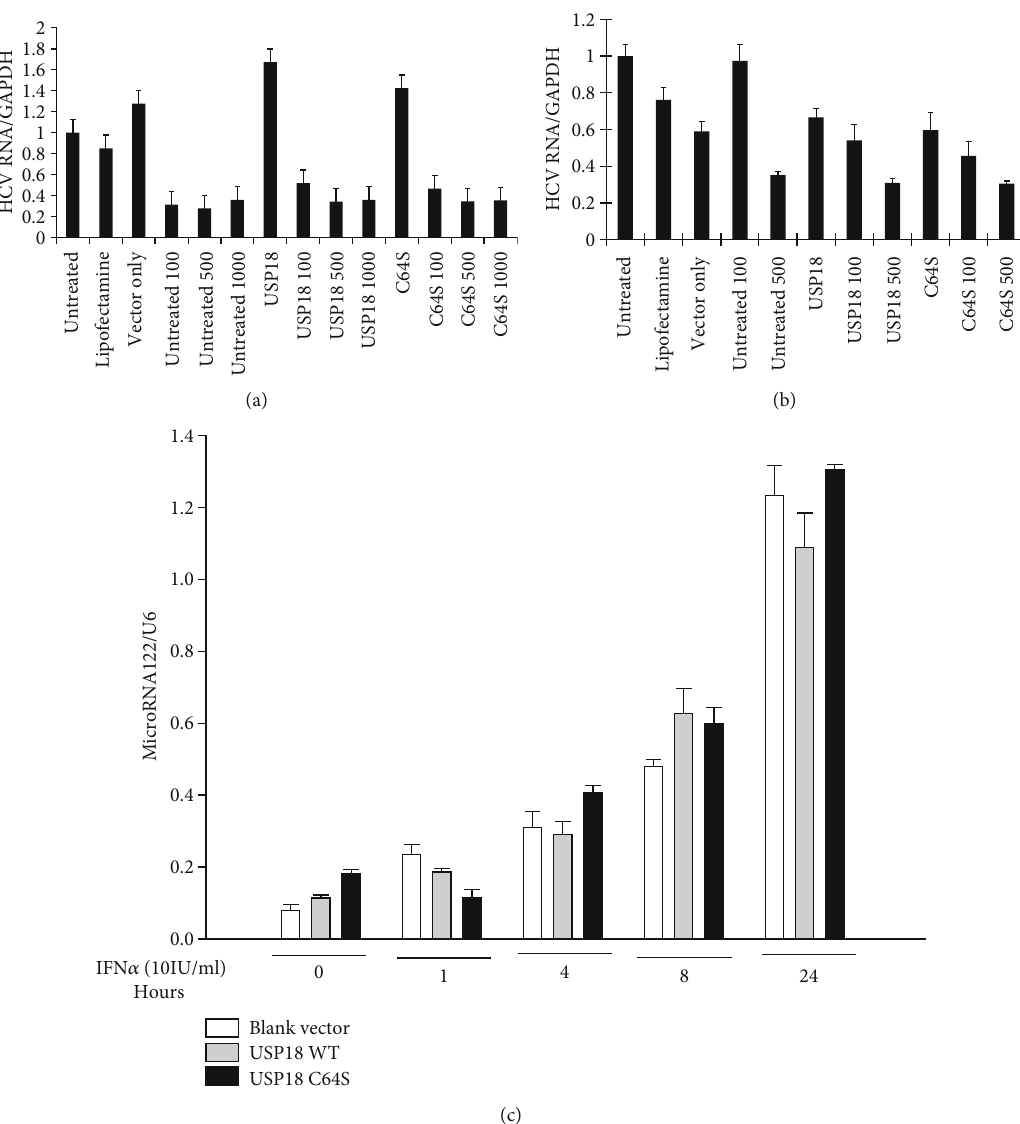
Figure 4: USP18 overexpression does not a ff ect HCV replicons nor microRNA122 expression. 5 × 10 5 AB12-A2 or sbJFH1-B2 cells were seeded overnight (6-well plates) before transfection with Lipofectamine 2000 in OptiMem with 4 μ g USP18 WT or USP18 C64S plasmid DNA. 24 hours posttransfection, protein was collected (RIPA bu ff er) or cells were treated with IFN α (Recombinant, Sigma) at 1, 100, 500, or 1000IU/ml in DMEM without antibiotics and incubated for 72h before RNA isolation. Total RNA was collected and subjected to real-time PCR assessment using primers speci fi c for HCV Con1b (a) or HCV JFH1 5 ′ UTR (b). (c) Huh7.5 cells were transfected with 4 μ g blank vector pcDNA-DEST53, 4 μ g USP18 WT, or 4 μ g USP18 C64S for 48 hours before treatment with IFN α (10 IU/ml). MicroRNA 122 levels were determined by a kit and normalized to U6 at di ff erent time points indicated post-IFN α treatment. Results are presented as means ± SD ( n ≥ 3